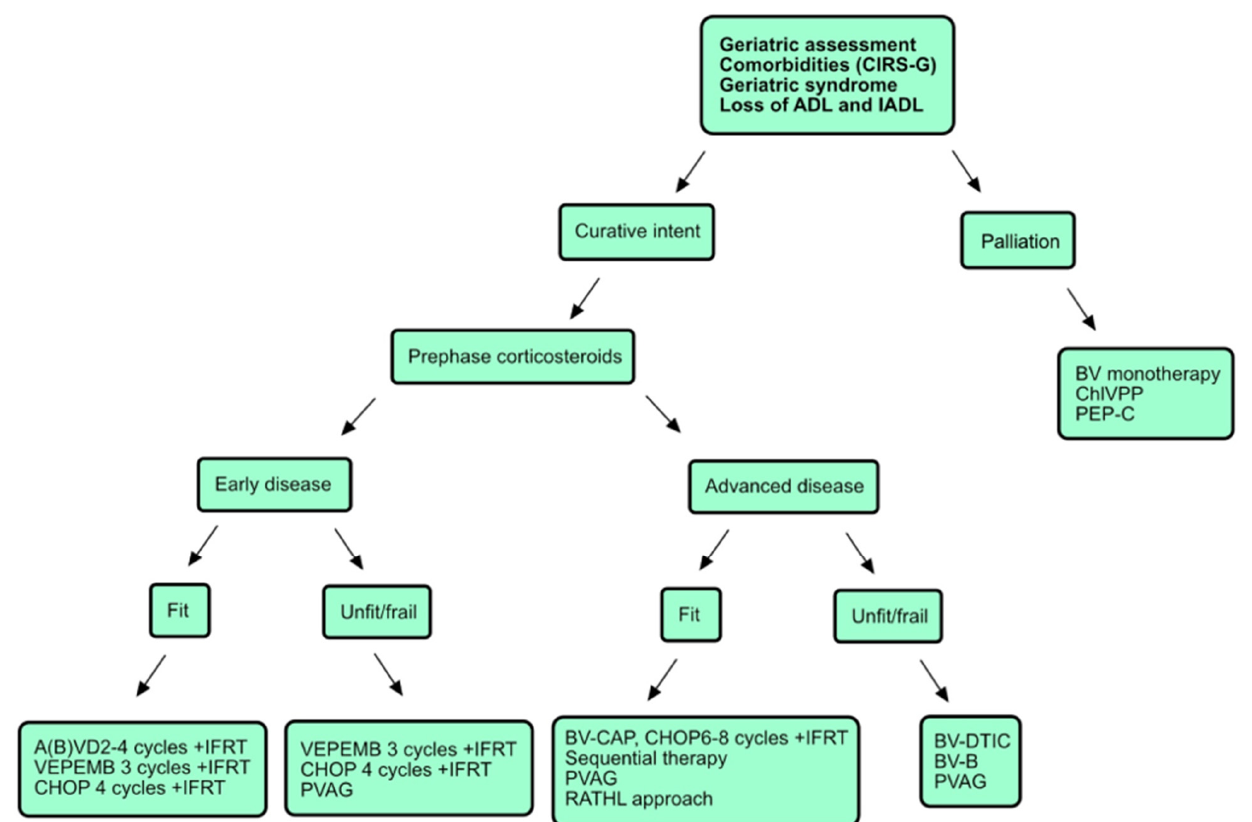
Figure 1. Proposed Treatment Algorithm for the First-Line Treatment of Elderly Patients with Hodgkin Lymphoma. Abbreviations: CIRS-G—Cumulative Illness Rating Scale-G;